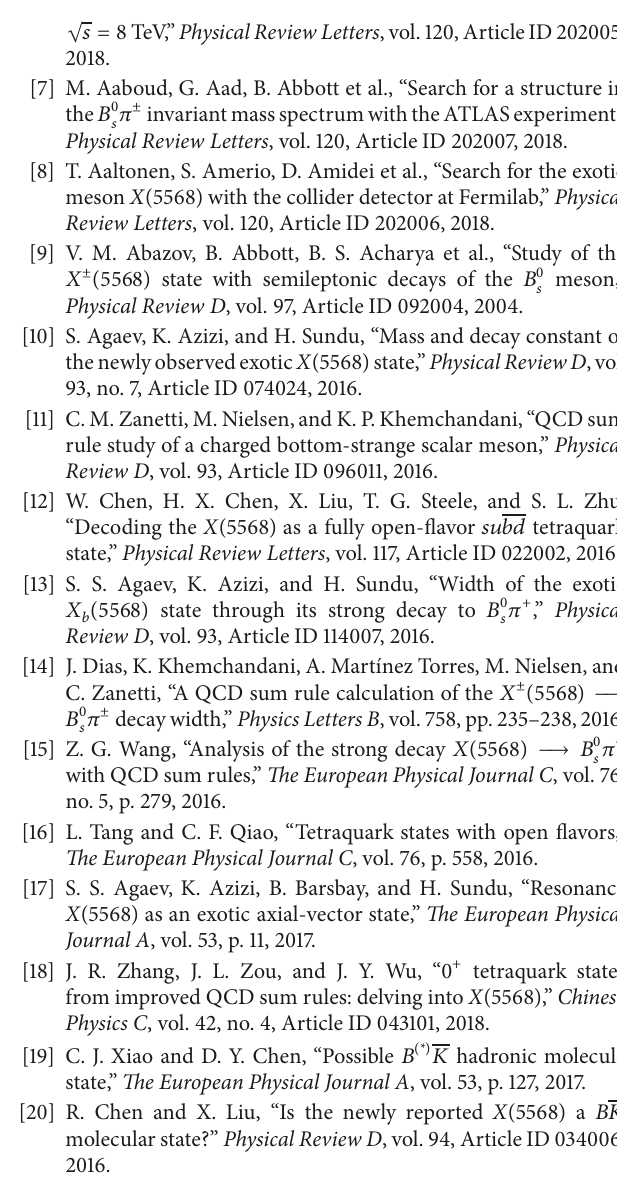
Figure 2: Relation of the cutoff Λ and the binding energy 𝐸 푏 with (a) the monopole form factor and (b) the dipole form factor for 𝐼 = 1 .